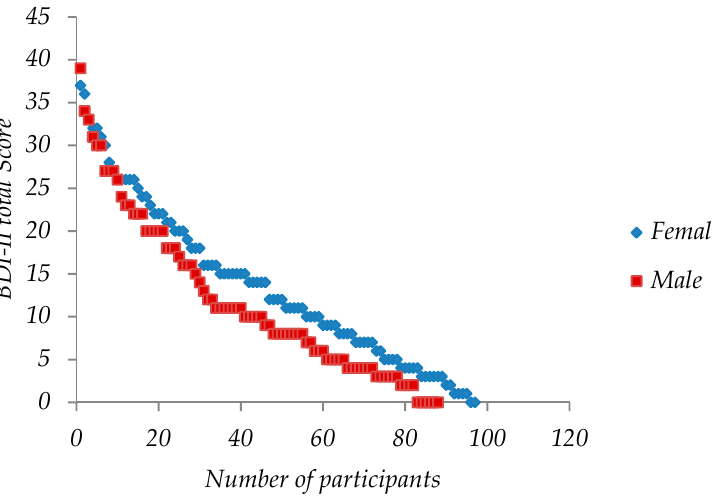
Figure 2. Dispersion plot of BDI-II scores by gender.